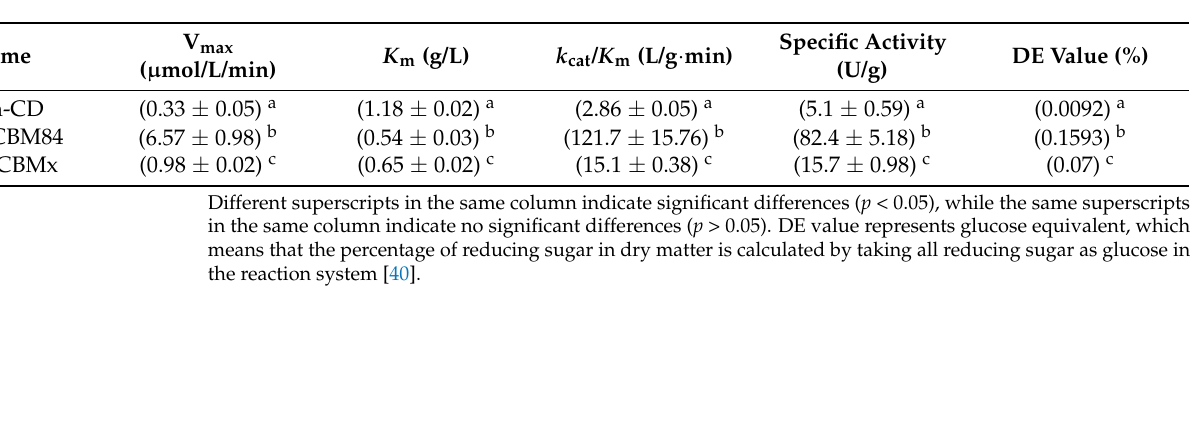
Table 3. Hydrolysis properties of the endotype xanthanases toward the xanthan backbone